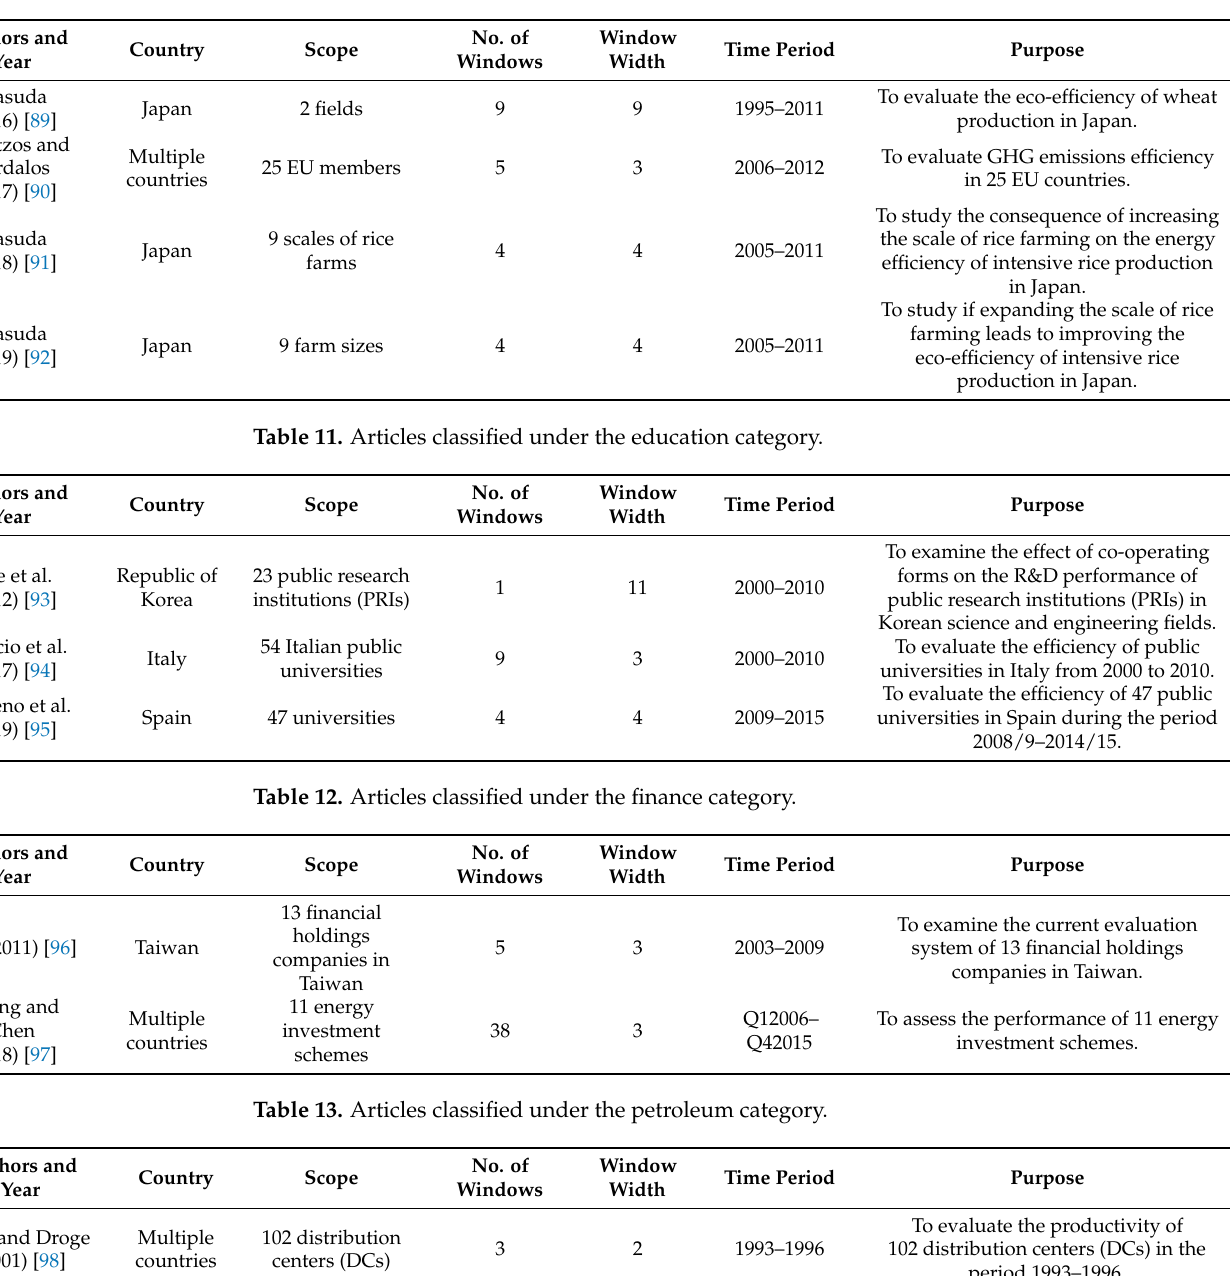
Table 10. Articles classified under the agriculture category.